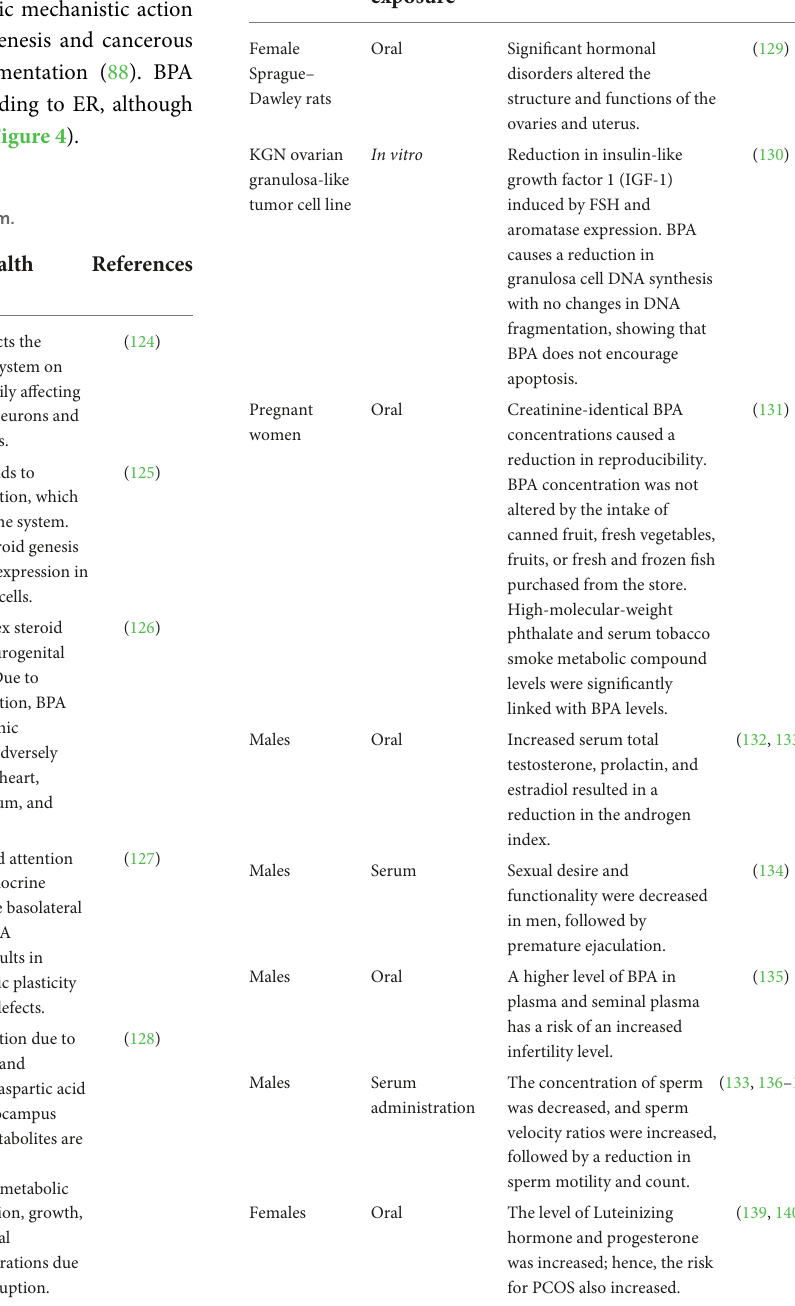
TABLE 3 Impact of BPA on the reproductive